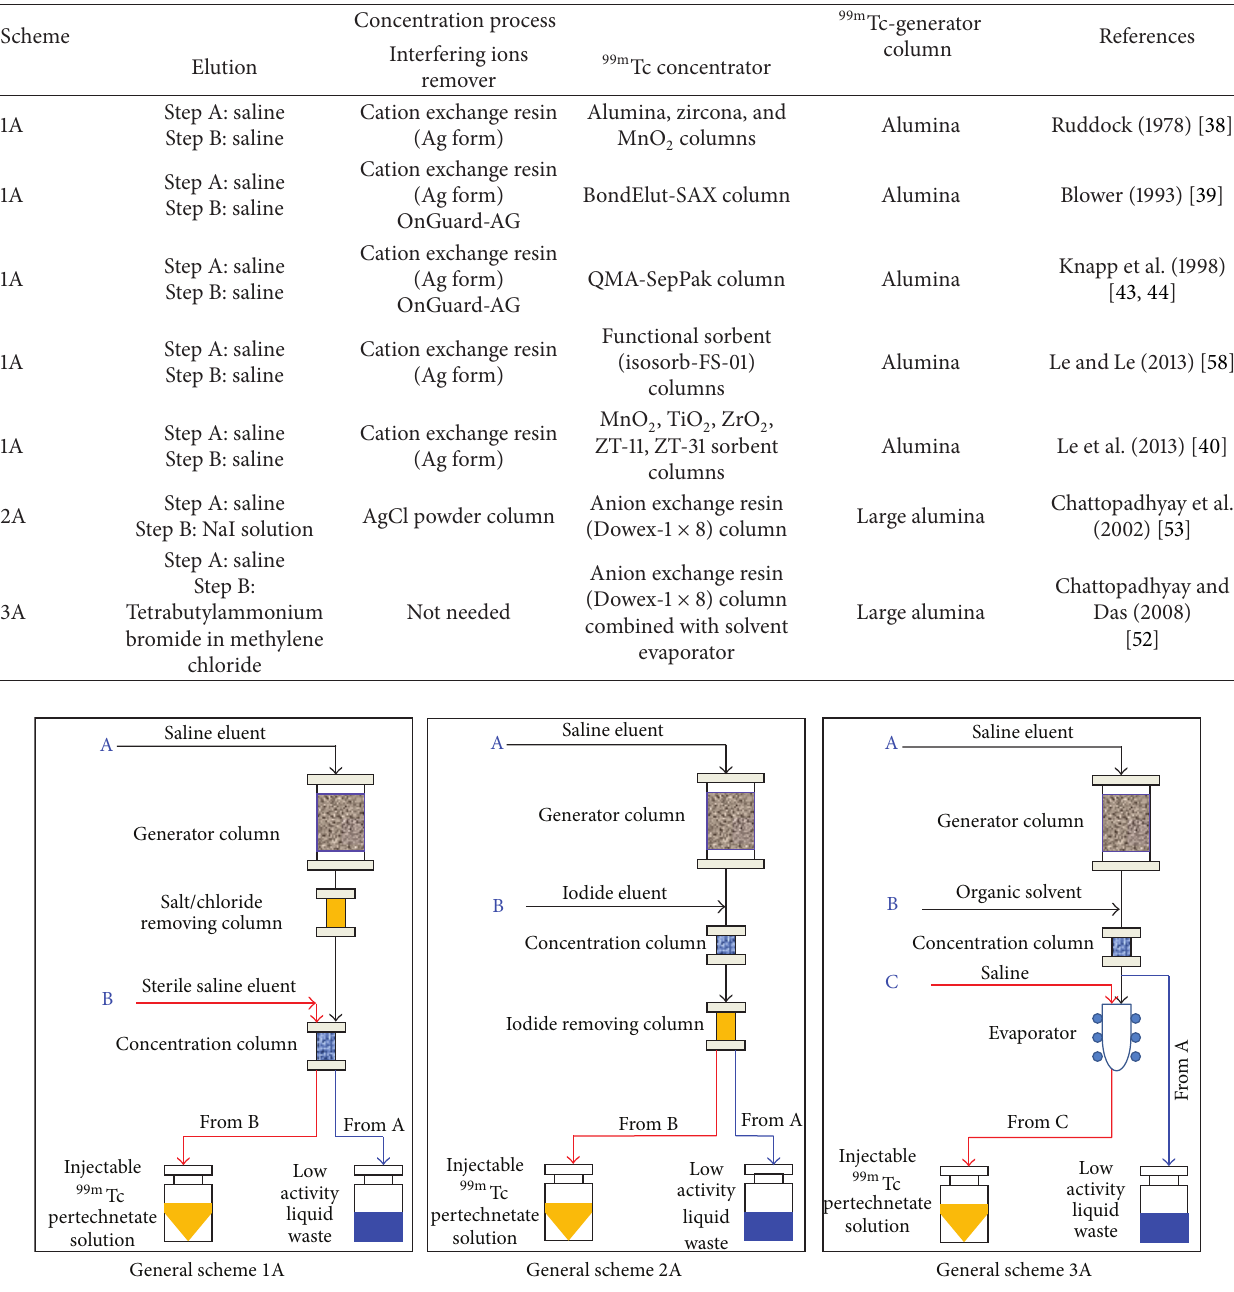
Table 4: Details of the methods of 99m Tc-pertechnetate concentration from the saline eluate of 99m Tc-pertechnetate (dual column concentration methods).